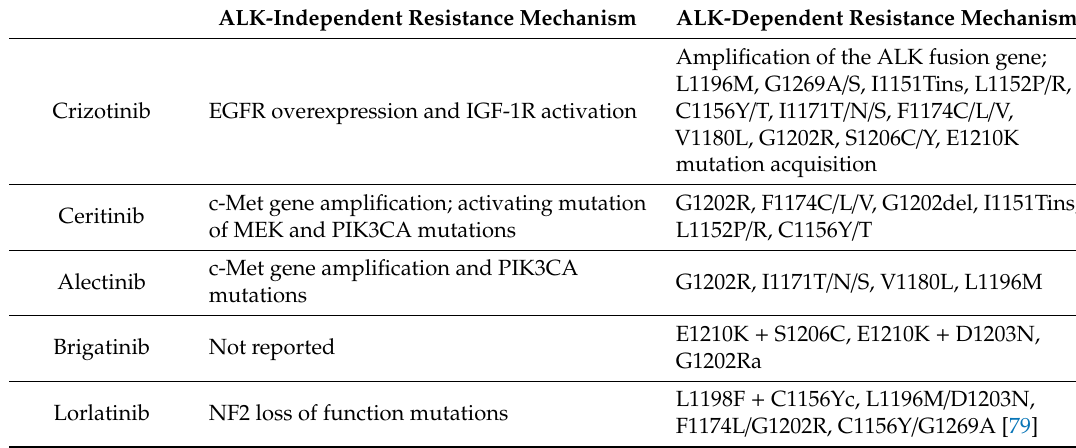
Table 4. Principal mechanisms of resistance to ALK